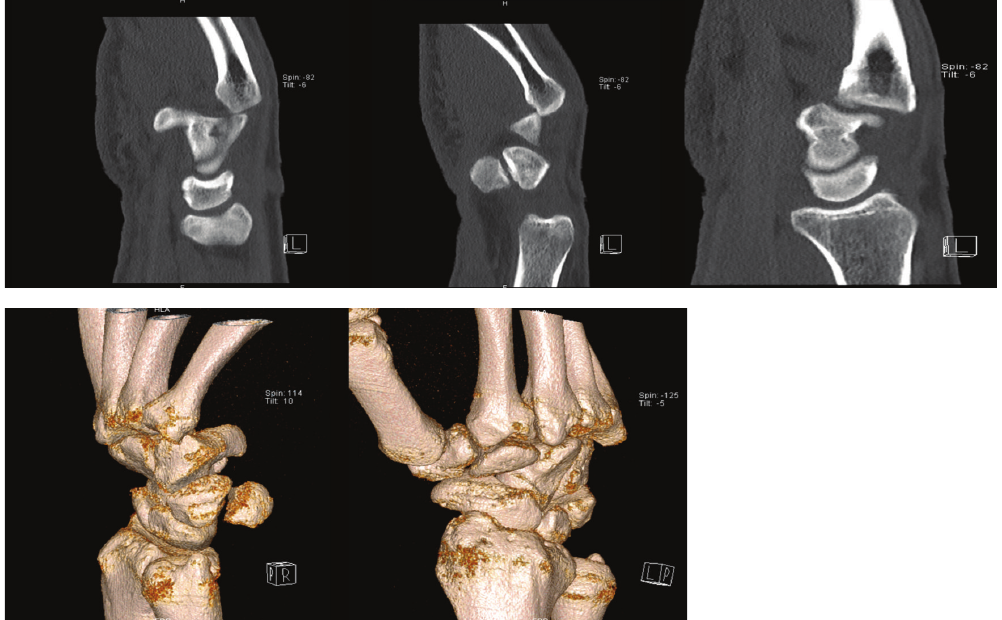
Figure 2: Complementary CT scan showing no other lesions than complete dislocation of the fourth and fifth CMC joints and a partial dislocation of the third CMC